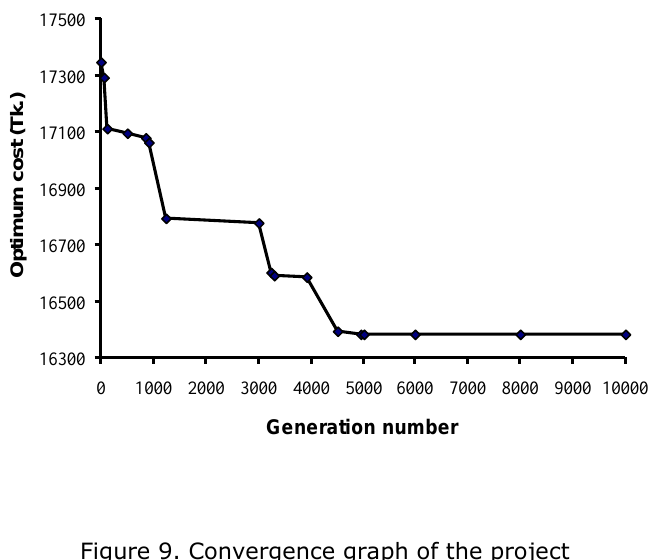
Figure 9. Convergence graph of the